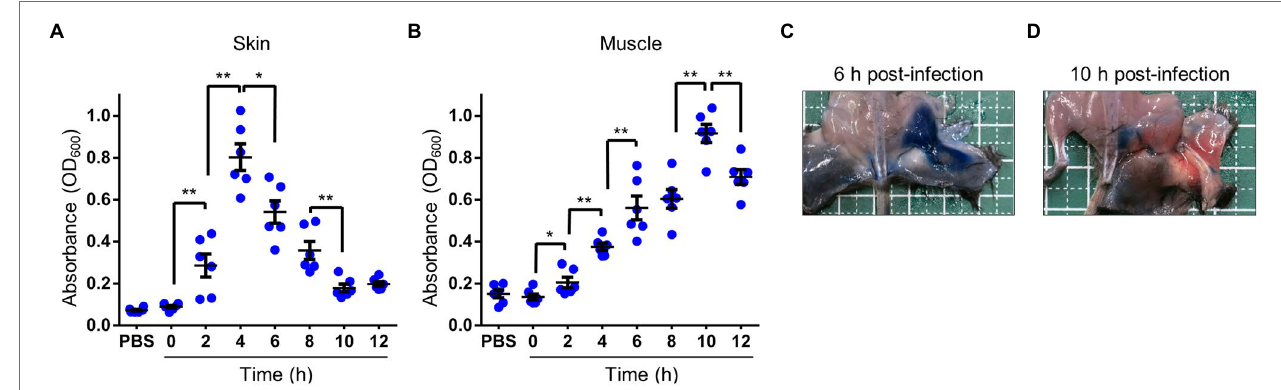
FIGURE 2 | Increased vascular permeability in soft tissues. (A–D) Thirty minutes before euthanasia, infected mice were injected i.v. with 0.1 ml of 5 mg/ml Evans blue dye. (A,B) Quantification of Evans blue dye extracted from the skin and subcutaneous tissue (A) or muscle tissue (B) in infected mice. Each symbol represents an individual optical density at 600 nm (OD 600 ; n = 6/group). Error bars indicate SEM. * p < 0.05; ** p < 0.01; Mann–Whitney U -test. (C,D) Appearance at 30 min after i.v.-inoculation with Evans-blue and 6 h after inoculation (C) and 10 h after subcutaneously inoculation (D) with wild type (WT). Blue spots caused by extravasation of the Evans blue-serum albumin complex were observed via peeling murine skin.